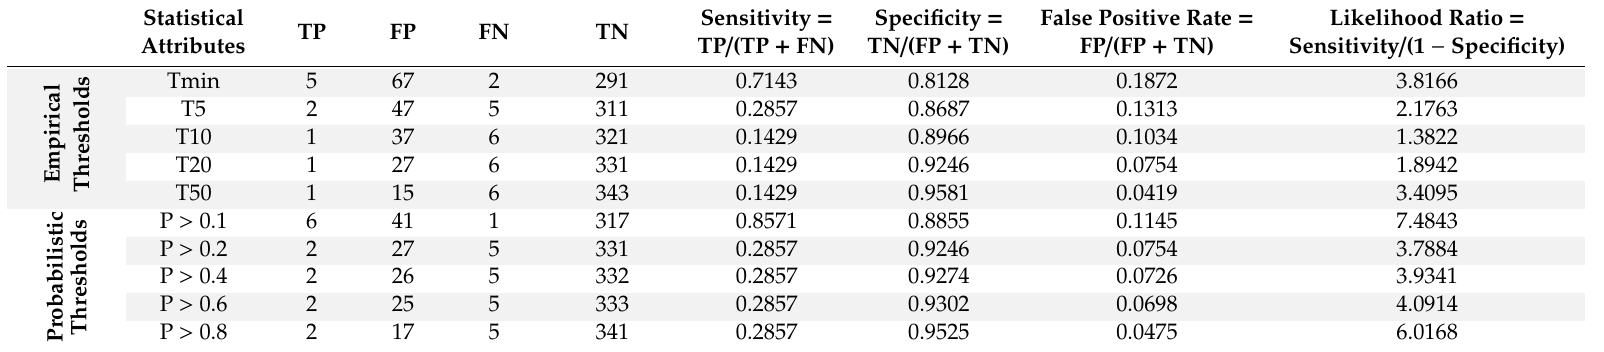
Table 4. Results of validation of empirical and probabilistic